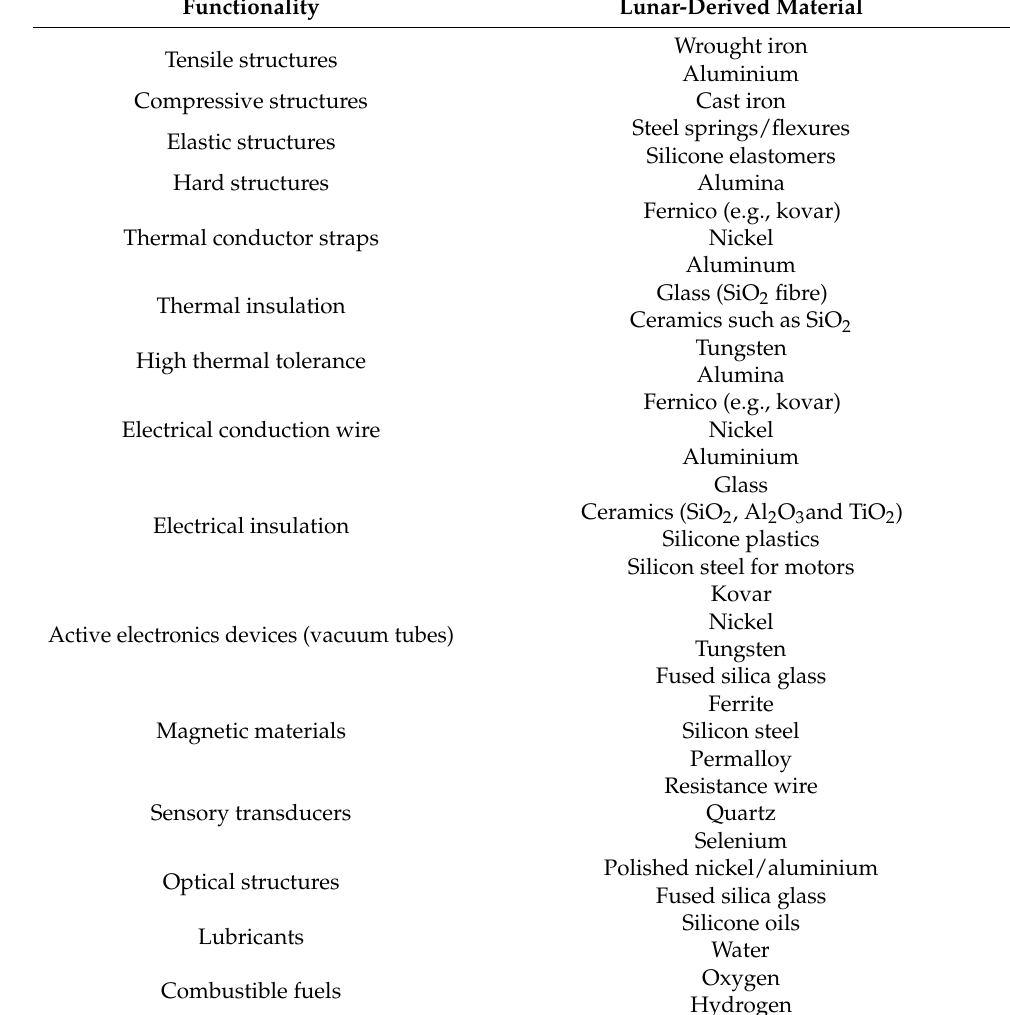
Table 1. List of desired materials (demandite) based on functional requirements for a generic